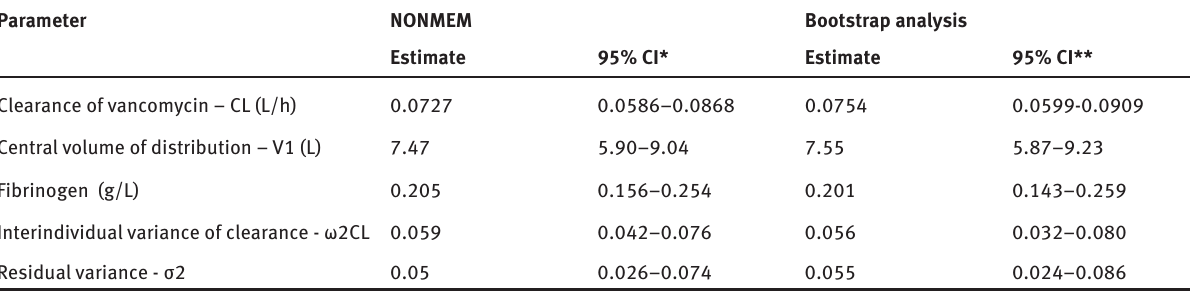
Table 2: The final model parameter estimates in population with normal renal